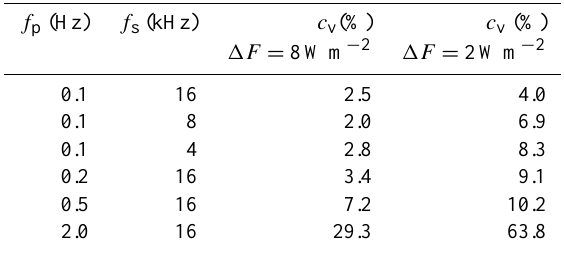
Table 1. Normalized percentaged SD c v between original and re- constructed irradiance for measurements of different oscillations, as illustrated in Figs. 4 and